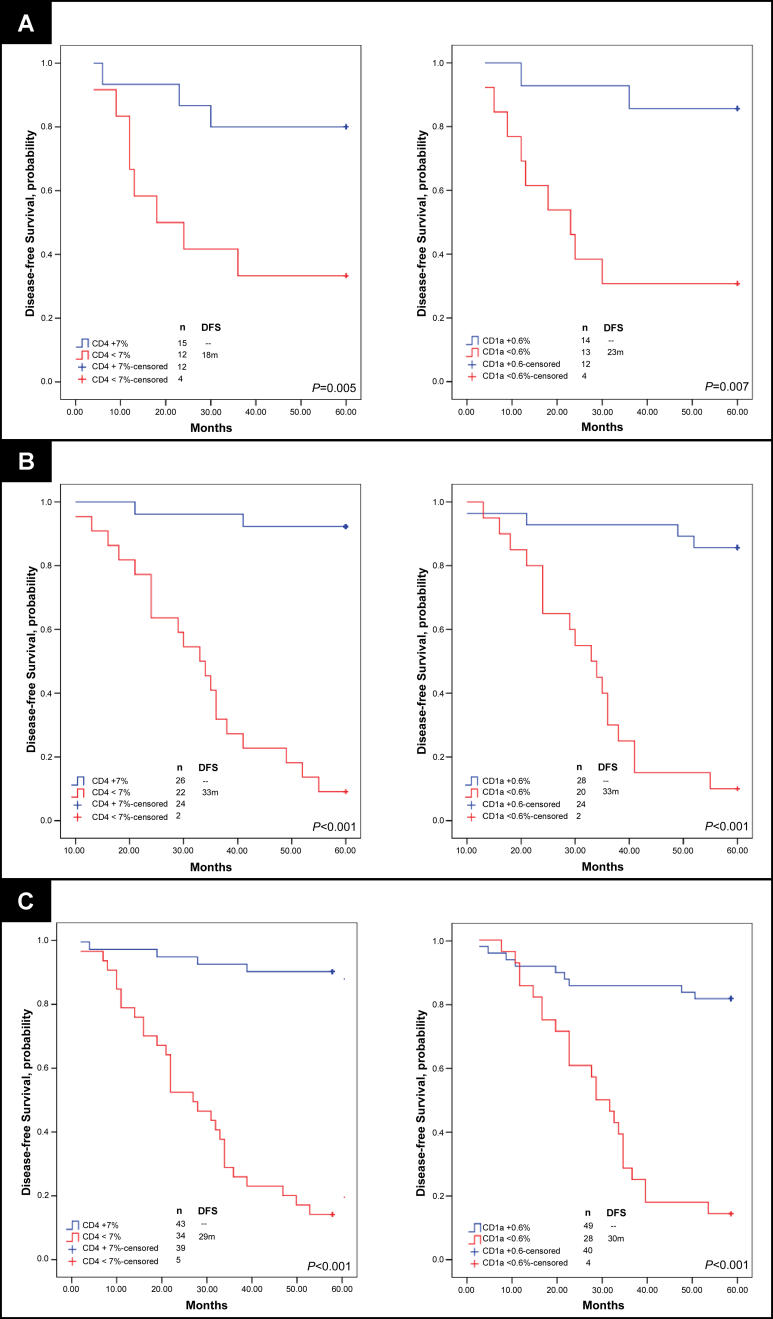
DFS Analysis of Women with Breast Cancer According to Tumor and Immune profile Characteristics, Learning Set ALN Series 1KM curves are shown for (A) median DFS applied to the learning set, n = 29, according to percent of SLN occupied by infiltrating tumor (determined by IHC), and stratified by tumor stage; (B) DFS according to size of CD4 T cell and CD1a dendritic cell populations within learning set ALN series 1 (first, arbitrarily selected ALN per individual); and (C) DFS stratified both by percent of SLN infiltrated by tumor and tumor stage, and by both axillary node CD4 T cell population and by tumor stage. A comparison of survival by all subgroups and a separate comparison of stratified T2 alone are included (* in [C]). Thresholds for percent tumor infiltration within SLN, ALN CD4 T cell, and ALN CD1a dendritic cell populations were determined by ROC curves as applied to the learning set (SLN and ALN series 1). Median duration of DFS are indicated; – indicates a median DFS greater than follow-up period, 5 y. Of 29 individuals, 11 had recurrent disease. Adjusted p-values were determined by the permuted log-rank statistic for comparison of disease-free survival between groups.TI, tumor infiltration.